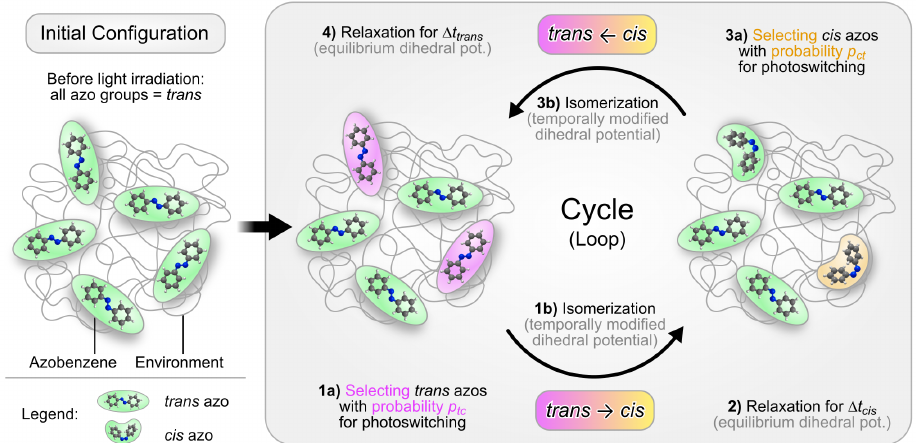
Figure 3. Illustration of the general sequence of events in the cyclic photoisomerization model. The system is composed of the light-reactive azobenzene groups and their environment (all photoinert parts of the system). The right-hand side depicts the simulation protocol for the photo-induced effects. Each photoisomerization cycle proceeds along steps 1–4 in a looped manner, repeated N